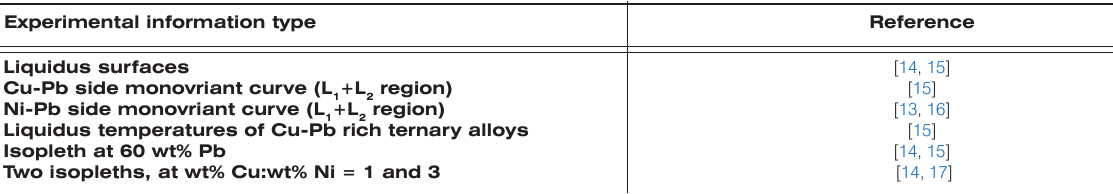
Table 1. Experimental information applied in the optimization